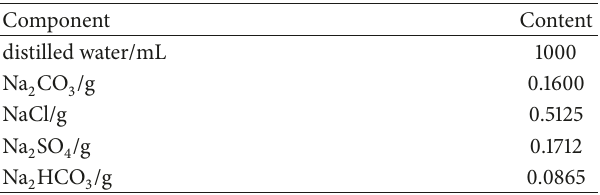
Table 1: The composition of soil simulated solution. Component Content distilled water/mL 1000 Na 2 CO 3 /g